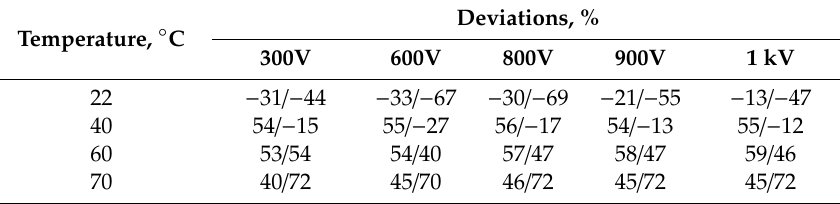
Table 3. Deviations of K v values for materials A and B (shown as the ration A/B), obtained from the SPD characteristics at different temperatures, as compared to the standard measurements.